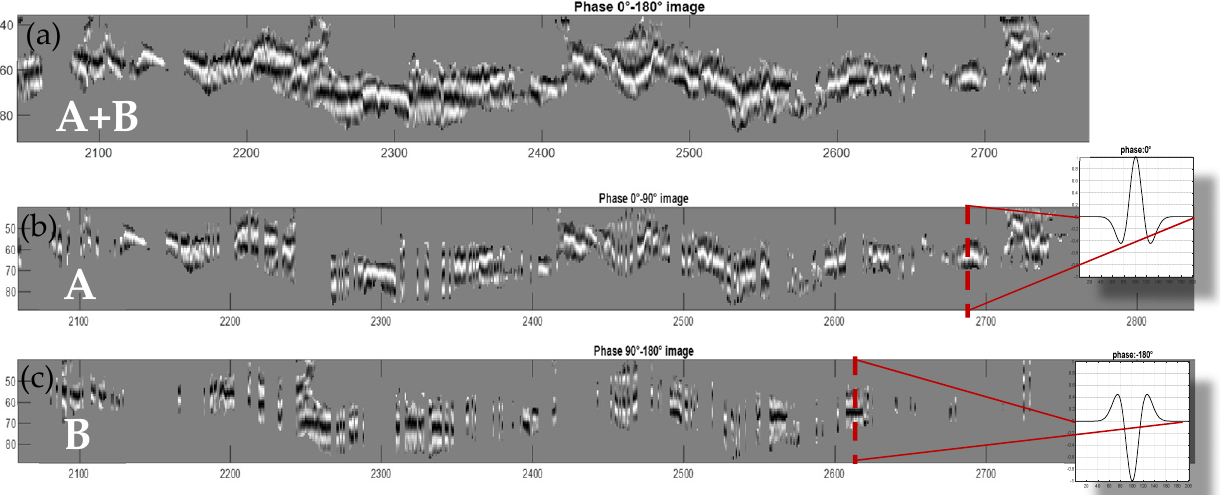
Figure 13. The extracted low-frequency radargram segment (segment ( a )) can be further segmented according to the phase angle of the individual radargram traces (segment ( b ) and segment ( c )).